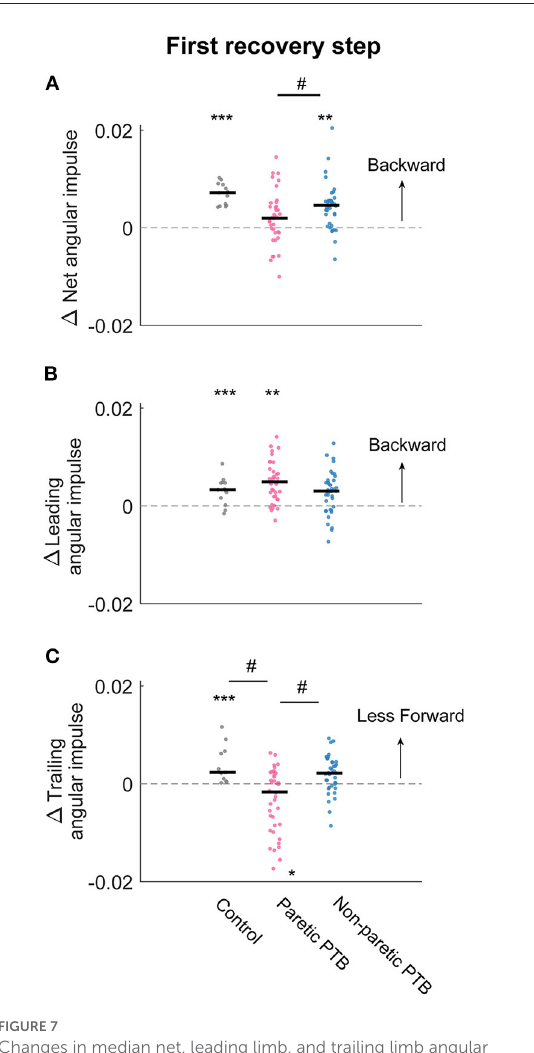
FIGURE7 Changes in median net, leading limb, and trailing limb angular impulse during the first recovery step compared to those measured during the pre-perturbation step. Changes in net angular impulse (A) , leading limb angular impulse (B) , and trailing limb angular impulse (C) during the first recovery step compared to the pre-perturbation step. Each dot represents one participant. Black horizontal lines indicate the median across participants. The asterisks (*) indicate whether values were statistically different from zero (*p < 0.05, **p < 0.001, ***p < 0.0001). The hashes (#) indicate when comparisons between groups are significantly different. Note that for people post-stroke, if the non-paretic leg was perturbed, the leading and trailing limbs corresponded to the paretic and non-paretic limbs during the first recovery step and vice versa for the paretic